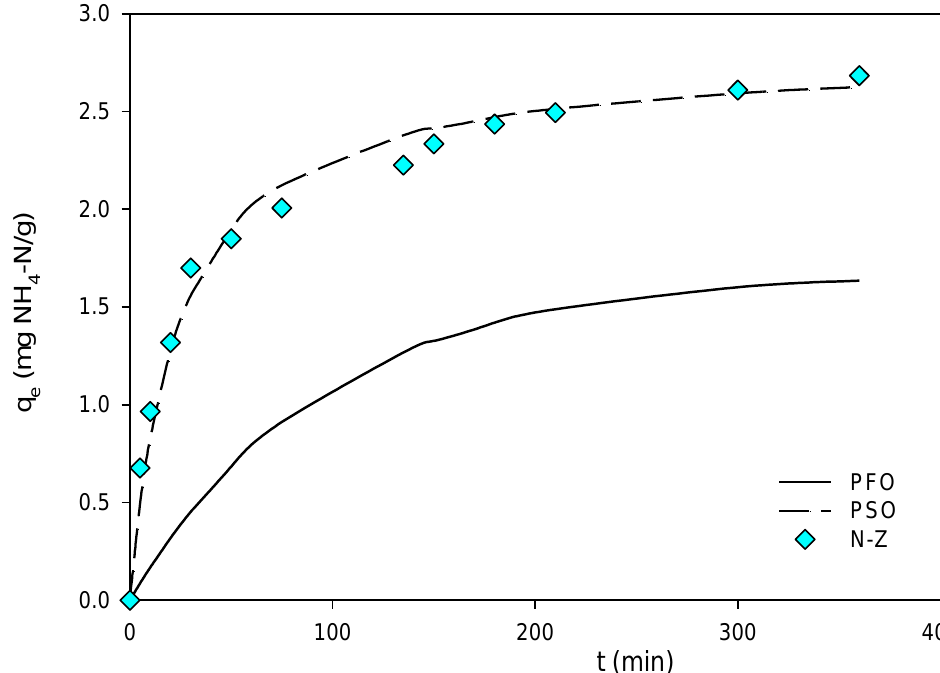
Figure 1. Pseudo-first- and pseudo-second-order kinetics of AnMBR permeate with N-Z. Table 2. Kinetic parameters for ammonium removal by N-Z and Purolite